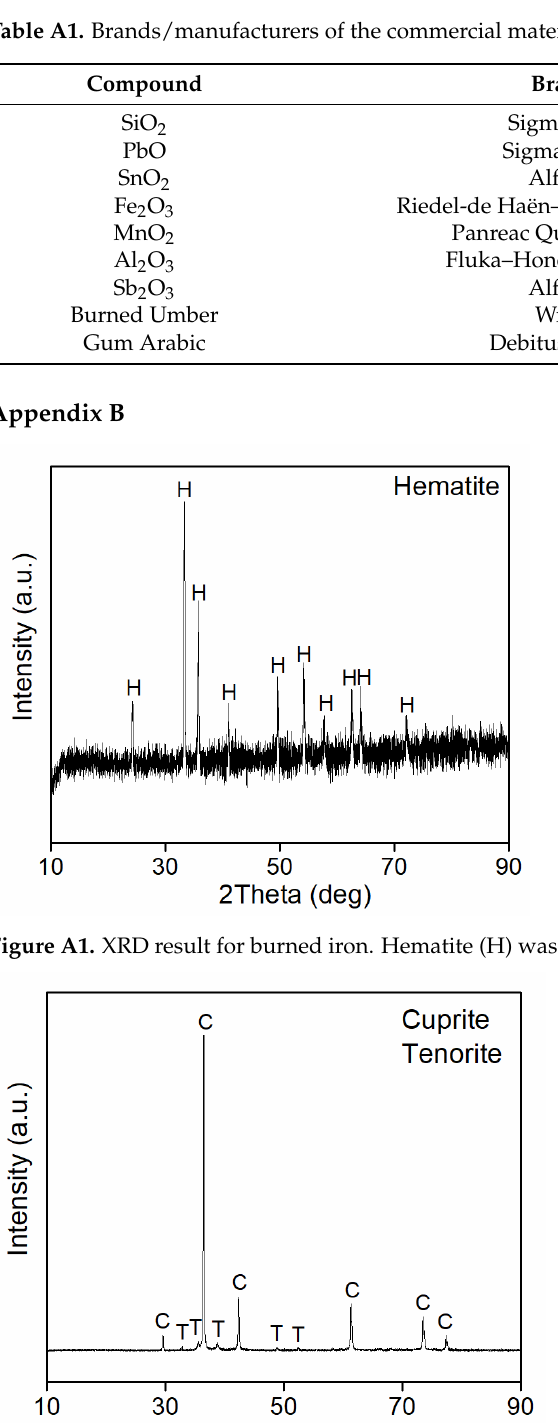
Figure A2. XRD result for burned copper. Cuprite (C) and tenorite (T) were identified.